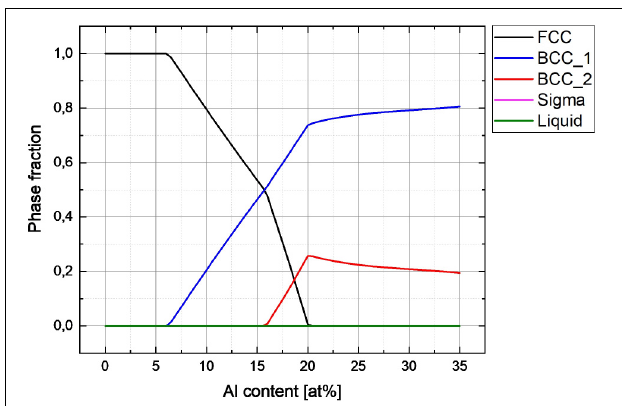
FIGURE 1 | CALPHAD calculation of the expected phase composition in the Al x CoCrFeNi alloy system at 1350 K in dependence on the Al content.